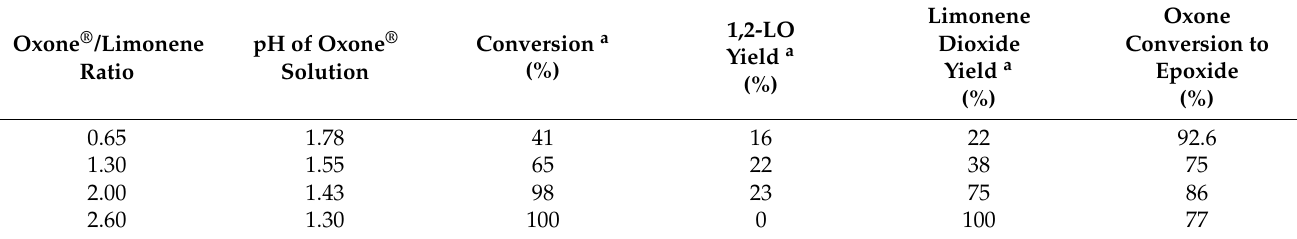
Table 1. Effect of total amount of oxone fed to reactor at constant flowrate [34].